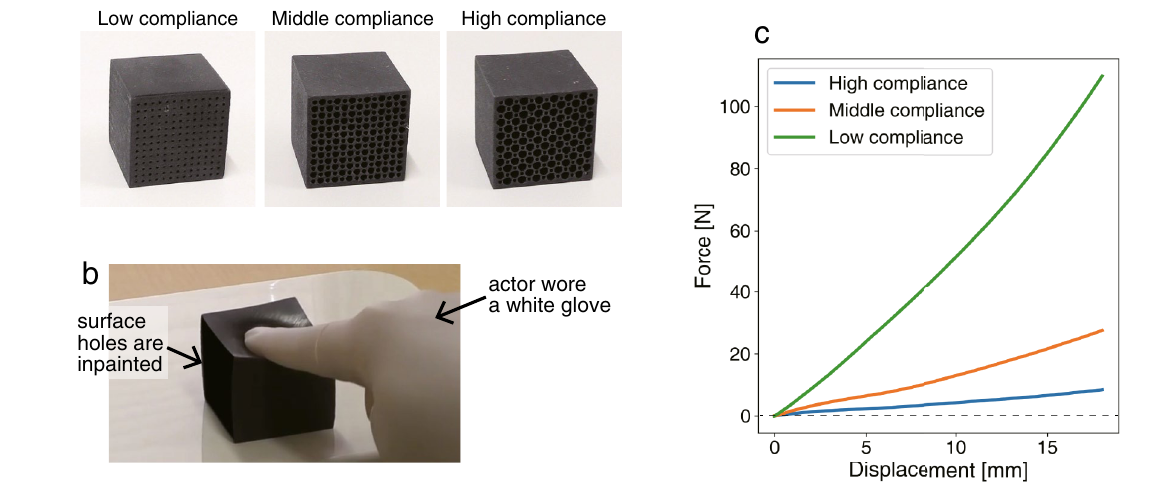
Figure 1. (a) Appearance of materials. The material compliance of the three materials was different due to the different sized cylindrical holes inside them. (b) Snapshot of a video clip. (c) Force–displacement curves of the